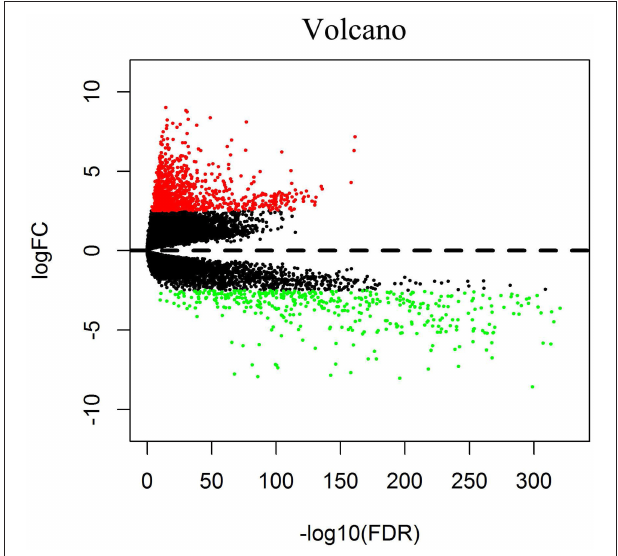
FIGURE 2 | Volcano diagrams of BC-related differentially expressed DEGs. Red dots represent upregulated DEGs, and green dots represent downregulated